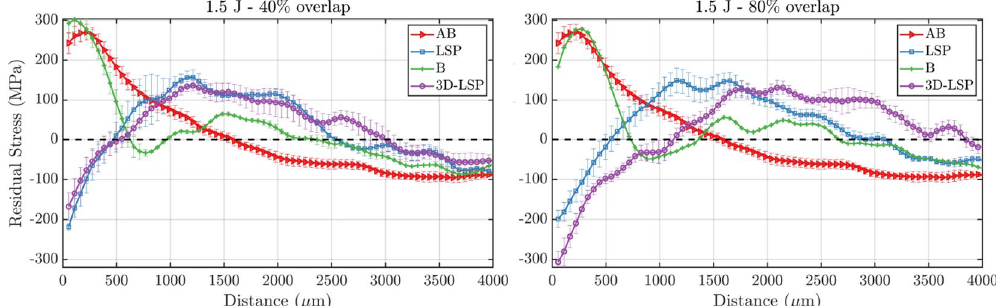
Figure 5. Average residual stress (MPa) as a function of distance from the top sample surface for different LSP techniques. The LSP process parameters were fixed to 1.5 J and 40 % overlap in the left frame and 1.5 J and 80 % overlap in the right frame. The color code and marker style are unique to each specific LSP technique.